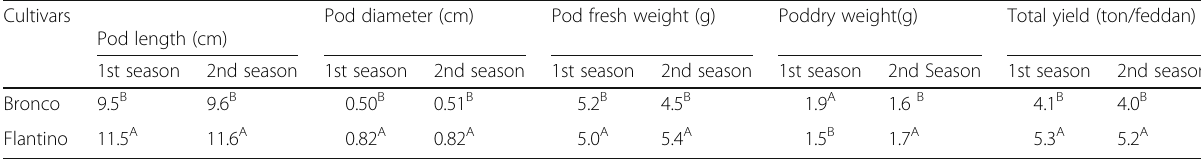
Table 5 Effect of cultivars on pod physical quality and yield of snap bean plants during 2017 and 2018 seasons Cultivars